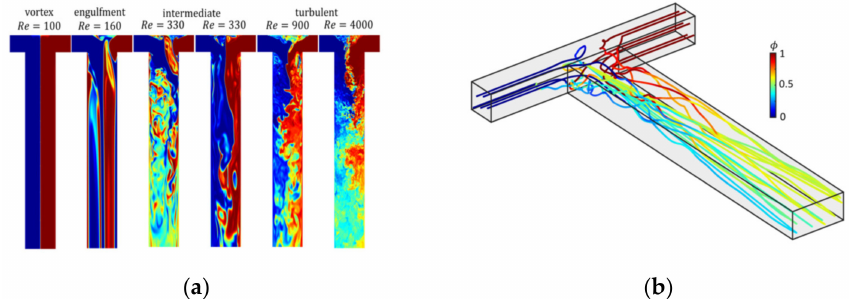
Figure 9. ( a ) Snapshots of the flow field in a T-mixer with increasing Re. Reproduced with permission from [55], Royal Society of Chemistry, 2019. ( b ) Lagrangian trajectories through the T-mixer, reprinted with permission from [50], Wiley,